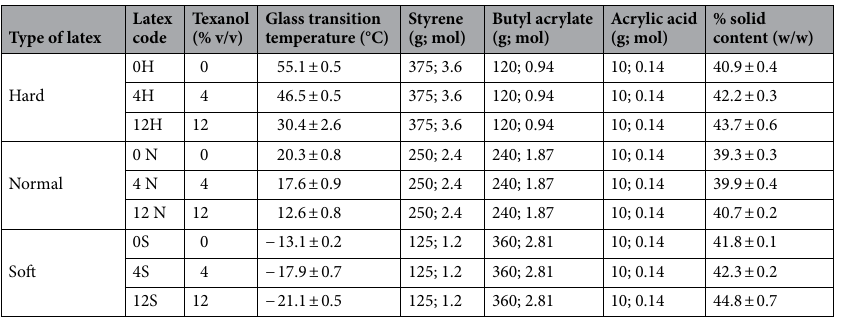
Table 2. Latex polymer composition, glass transition temperature and bulk properties. ‘Hard’ (H) latex had a styrene to butyl acrylate ratio of 1:3, ‘normal’ (N) was 1:1, and ‘soft’ (S) was 3:1. The preceding number in the latex code corresponds to the Texanol